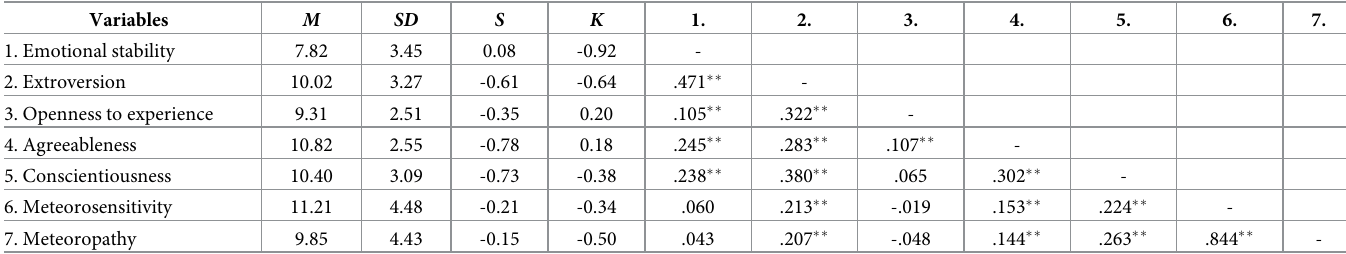
Table 2. Descriptive statistics and pearson correlation coefficients between analyzed variables in the full participant sample (N = 758). Variables